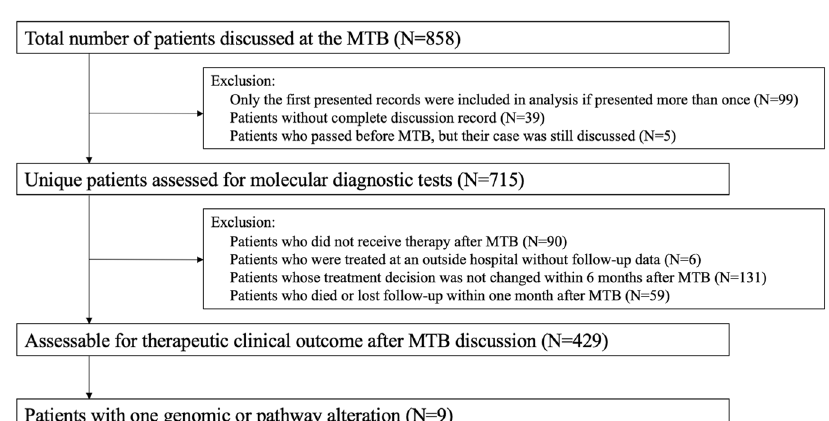
Fig. 1 CONSORT diagram of patients included in this study. Only solid tumors were included. Patients who had only one alteration on an initial pro fi ling test but subsequently had more genomic pro fi ling after MTB presentation and demonstrated additional alterations were excluded. All included patients had NGS pro fi ling. Patients were treated within six months of MTB. Patients who received immunotherapy based on MSI-high or TMB-high were not included in the current analysis 9